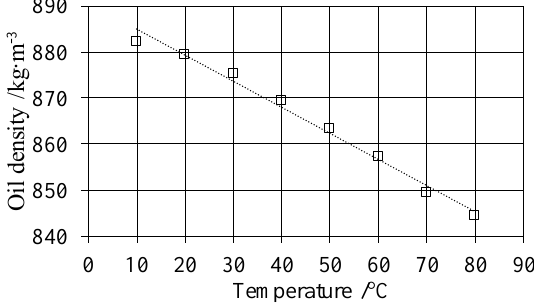
Fig. 2. Dependence of the oil density ρ O on the temperature t O .